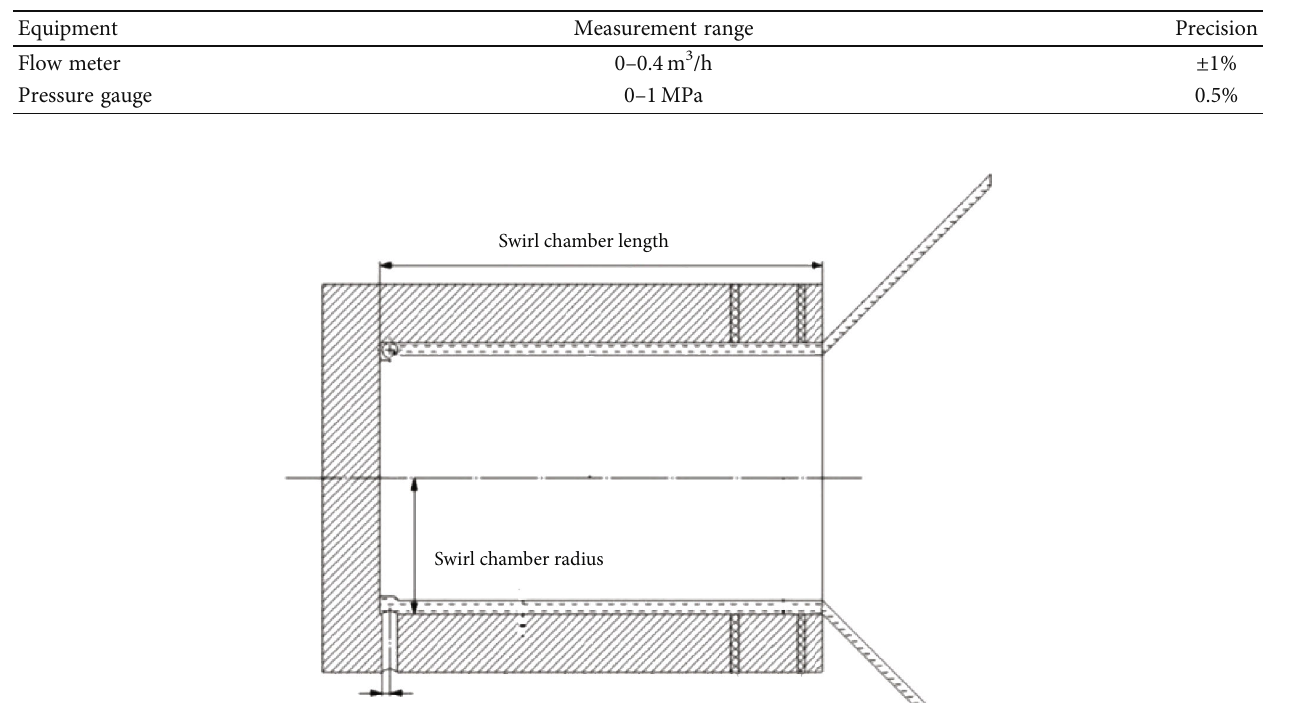
Figure 1: Experimental system. Table 1: Properties of experimental equipment.